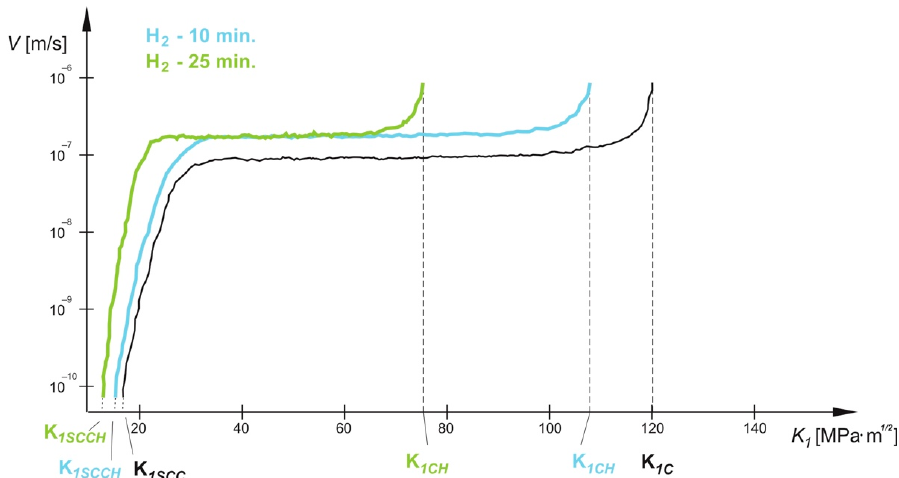
Figure 6. The dependence of the crack propagation rate on the value of the stress intensity factor K 1 for not-hydrogenated and hydrogenated (H 2 ) 5754 alloy—time of the hydrogenation: 10 and 25 min. K 1SCC —nucleation and growth of a stress corrosion crack; K 1SCCH —nucleation and growth of a stress corrosion crack after hydrogenation; K 1C —material separation; and K 1CH —material separation after hydrogenation.